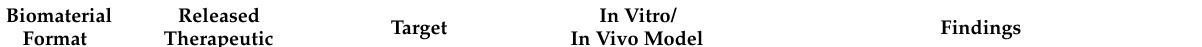
Table 1. Various silk fibroin formulations for local delivery of therapeutic agents in cancer treatment. Biomaterial